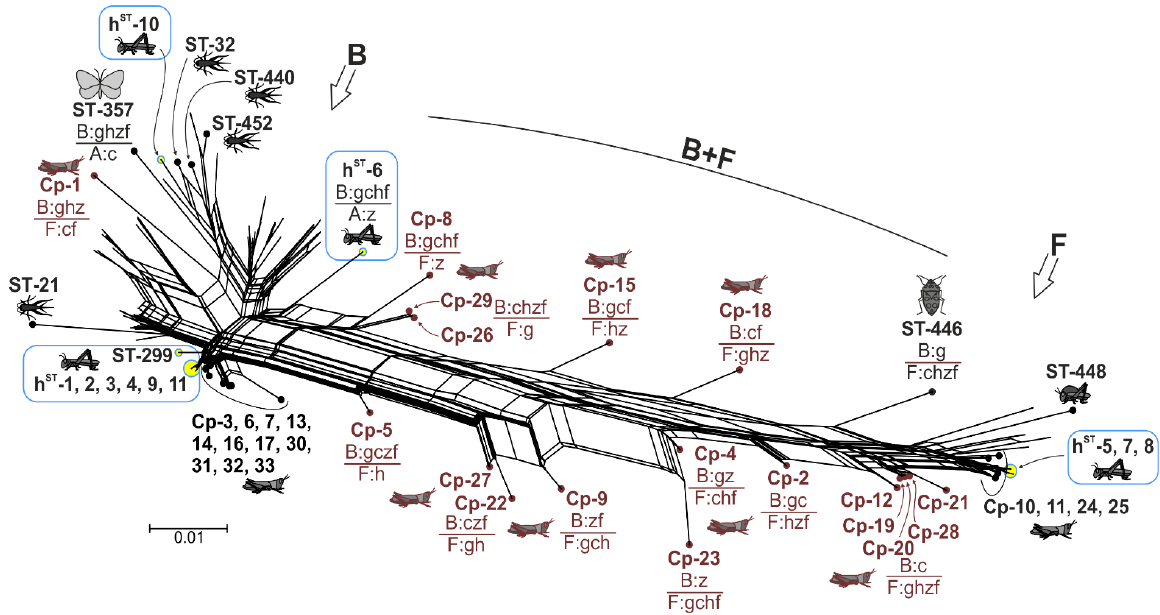
Figure 4. The phylogenetic network (NeighborNet) constructed in SplitsTree4 from 127 unique haplotypes (concatenated MLST genes). Branches with isolates from this study are highlighted in yellow, isolates from [44] (Cp) are in brown. The dataset of this figure differs from that in Figure 3 in the following ways: (1) the number of haplotypes was reduced (to decrease phylogenetic noise), (2) the alignment corresponds to haplotype data from [44]. Inter-supergroup recombinant haplotypes are designated as in Figure 3. See original files in Supplementary Materials.